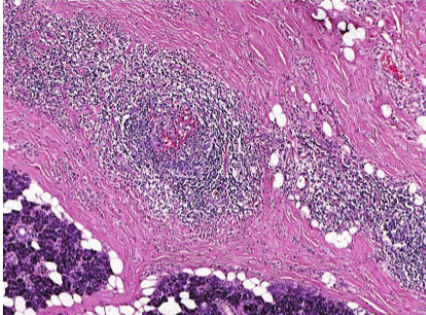
Figure 4: A diffuse chronic inflammatory cell infiltrate with germinal center formation and fibrosis (H&E staining, 40x).